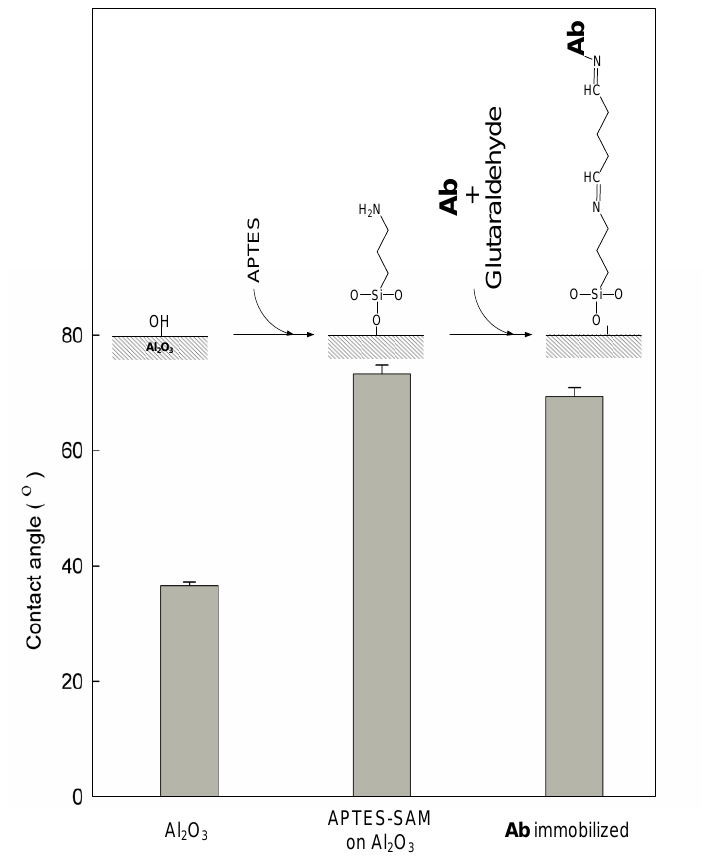
Figure 1. The schematic design of the deposition of APTES-SAMs and Ab immobilization on aluminum surface, and the changes of water contact angles on aluminum substrates as the formation of APTES-SAMs and Ab